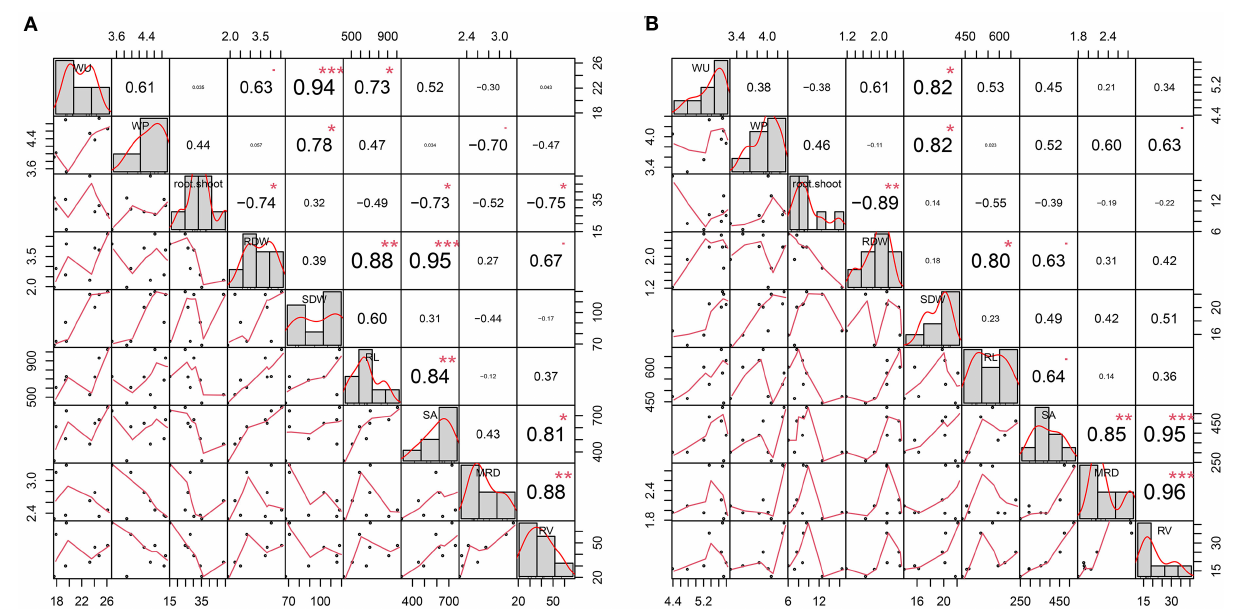
FIGURE 1 | Plot representing phenotypic distribution and correlation for water consumption (WU), water productivity (WP), root and shoot biomass (RDW and SDW, respectively), and root traits (RL, Root length; MRD, Mean Root Diameter; RV, Root Volume; SA, Surface Area), evaluated under well-watered (A) and water-deficit (B) conditions. The diagonal line of the plot shows the histograms and the distribution of the observed phenotype values. The lower off-diagonal is the scatterplot between the traits, whereas the upper off-diagonal represents the correlation value between traits. *, **, and *** denote the level of significance at 5, 1, and 0.1%,